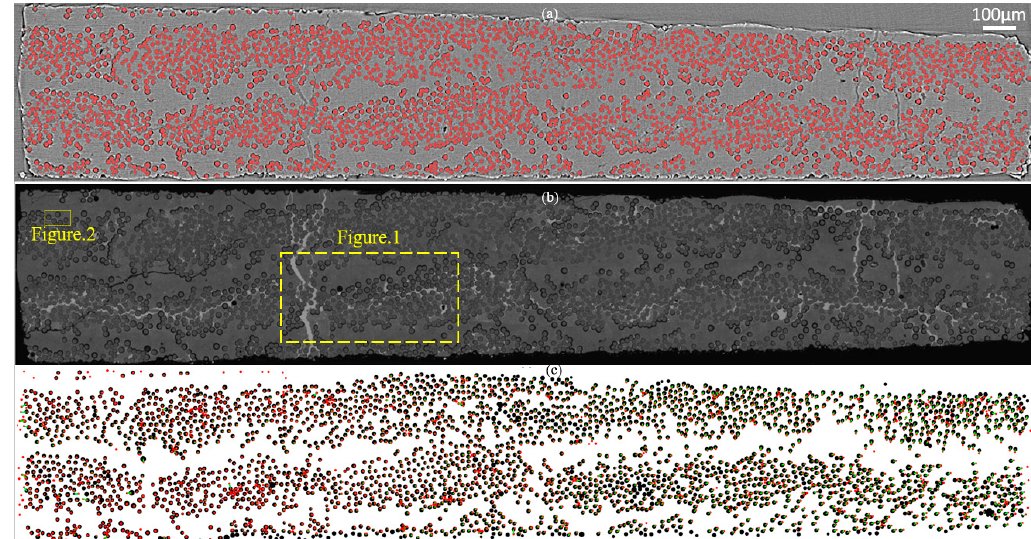
Figure A2. ( a ) Segmented CT cross-sectional image and its corresponding ( b ) optical image ( c ) alignment and correlation of optical and CT fiber segmentations optical fibers mask (black), CT fibers (red) and a line (green) joining center coordinates of fibers. The optical fiber to CT Fiber correlation and alignment has a tolerance of matching fibers centers 7 µm apart, to account for possible misalignment between cross-section slice in 3D CT and the sectioned/polished plane in optical.